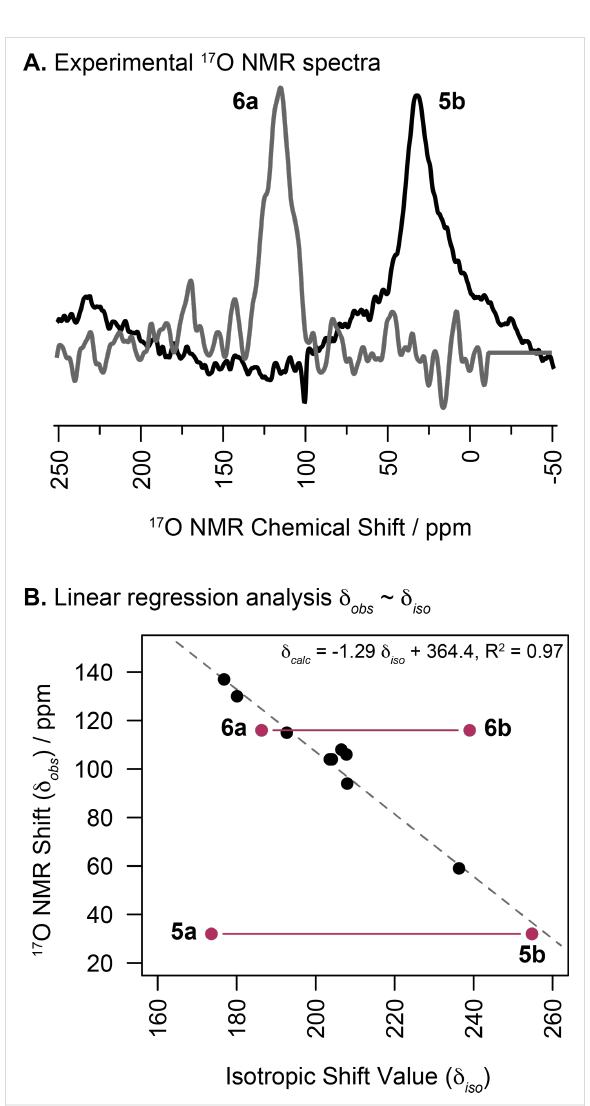
Figure 2: Assignment of acyclic ( b ) and cyclic ( a ) structures to 5 and 6 , respectively, based on computed isotropic shift values ( δ iso ) and ex- perimental 17 O NMR chemical shifts ( δ obs